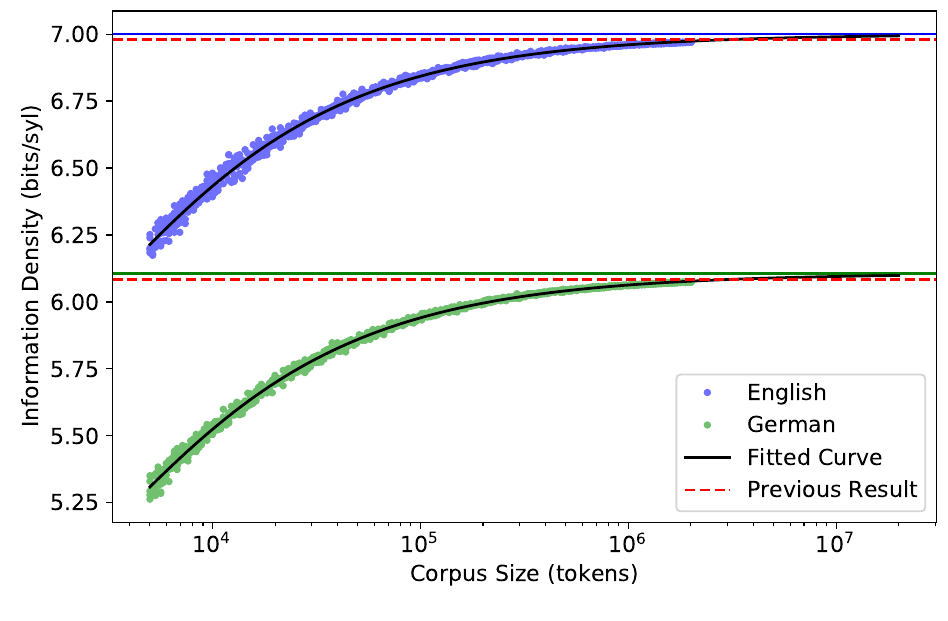
Figure 2. Information density extrapolated from small sub-corpora of English and German (solid line), compared to the result calculated from the entire corpus (dashed line). The difference sug- gests that expanding the full corpora by another order of magnitude would give us a slightly higher information